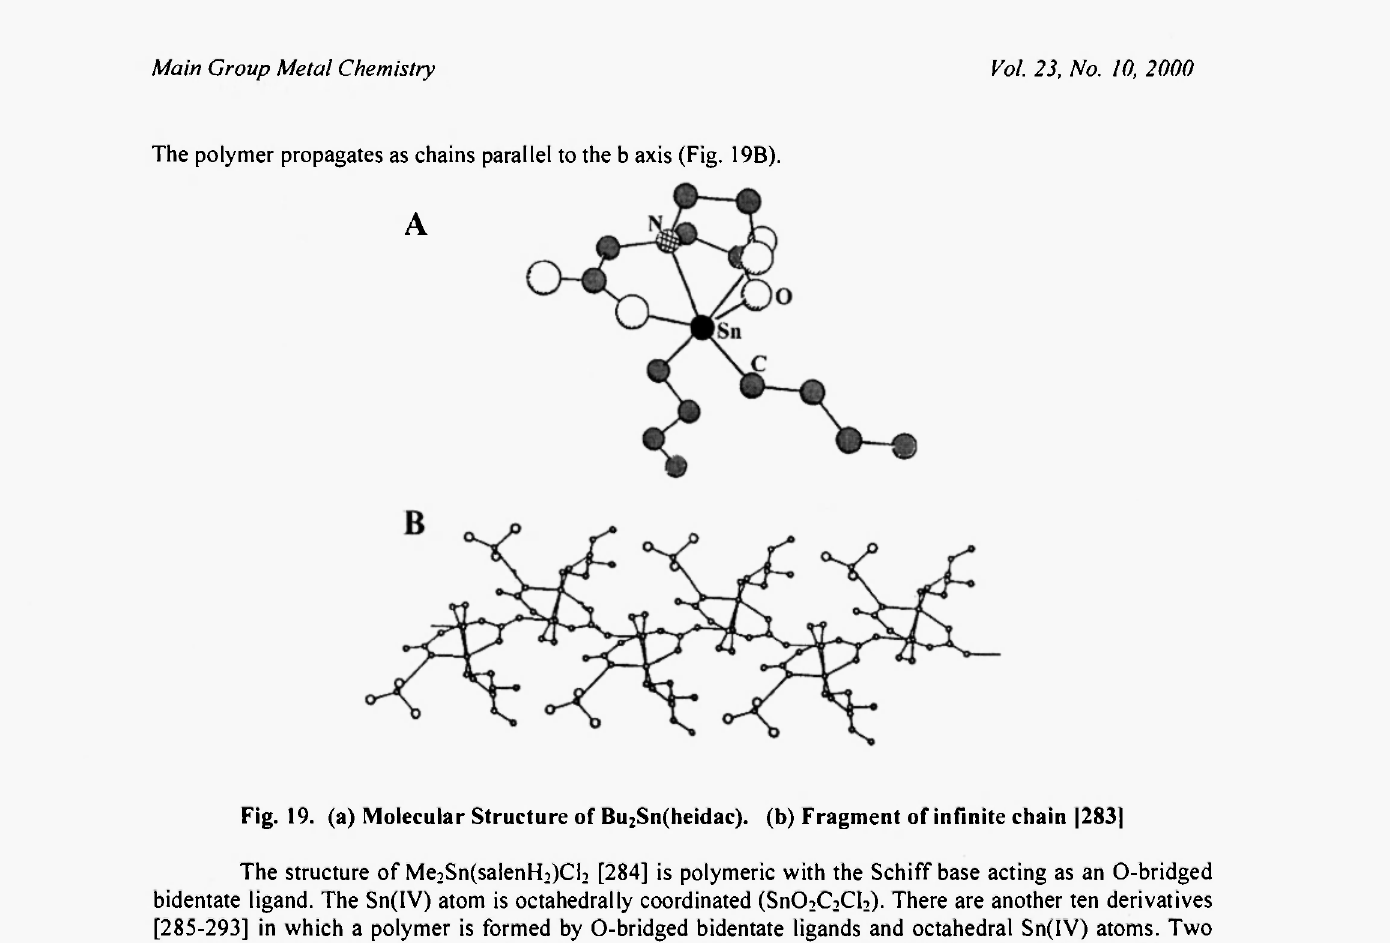
Fig. 19. (a) Molecular Structure of Bu 2 Sn(heidac). (b) Fragment of infinite chain